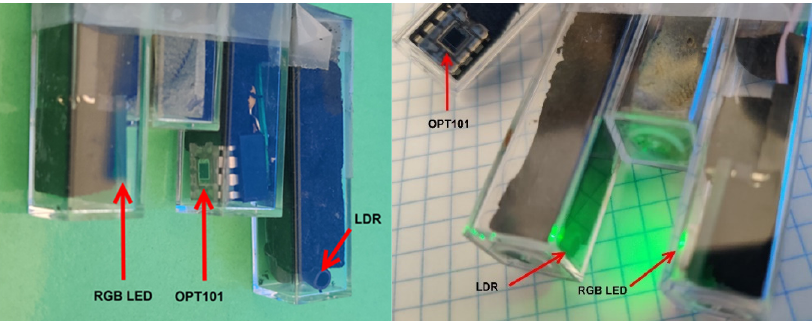
Figure 2. Colorimetric endpoint detector ensemble (LDR/OPT101_RGB_LED) showing the emitter, the light detectors, and the spatial arrangement.